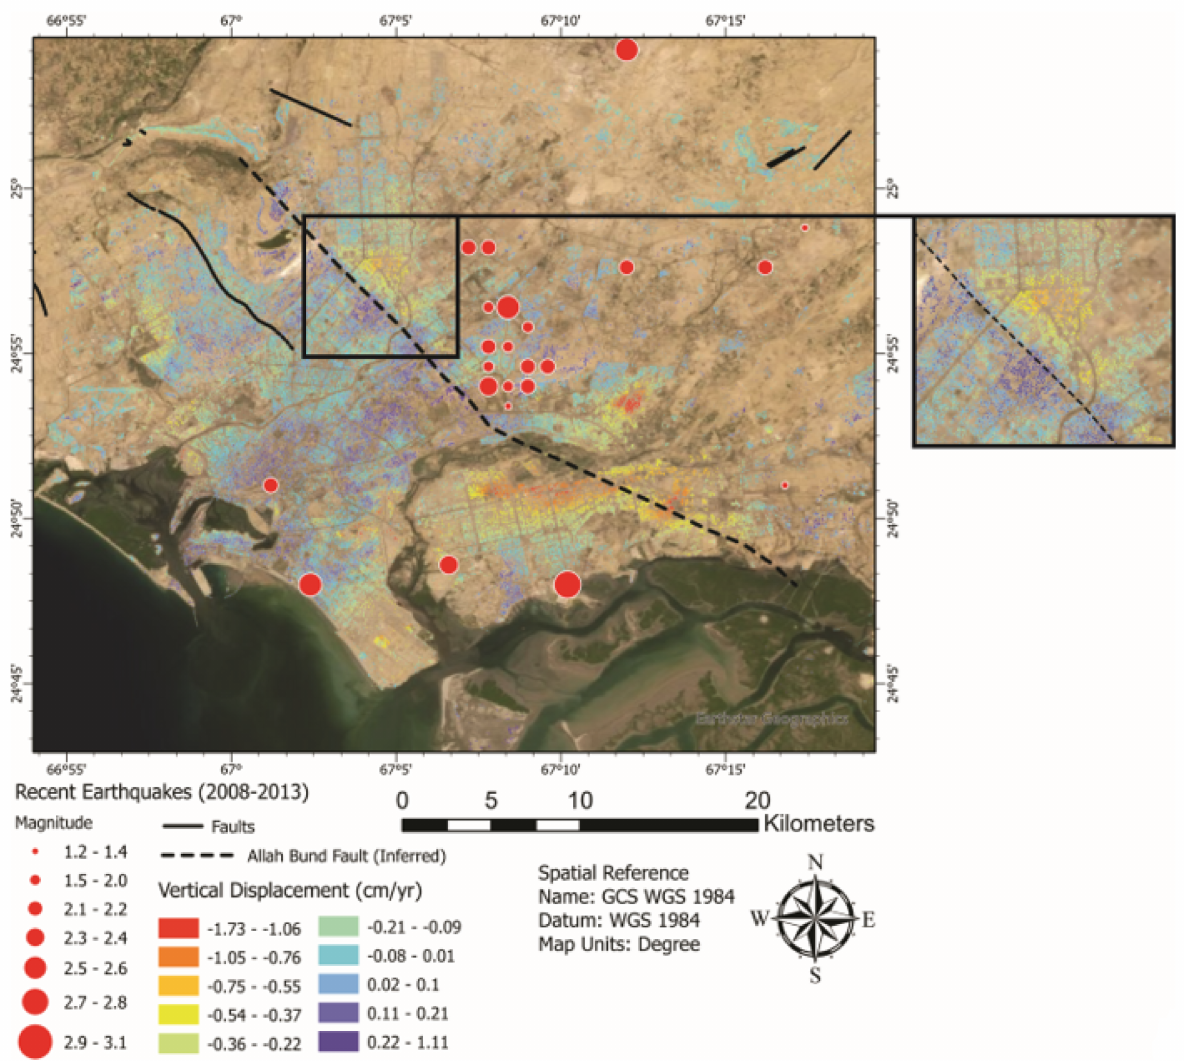
Figure 5. Vertical component of deformation from LOS velocity decomposition. Negative values indicate